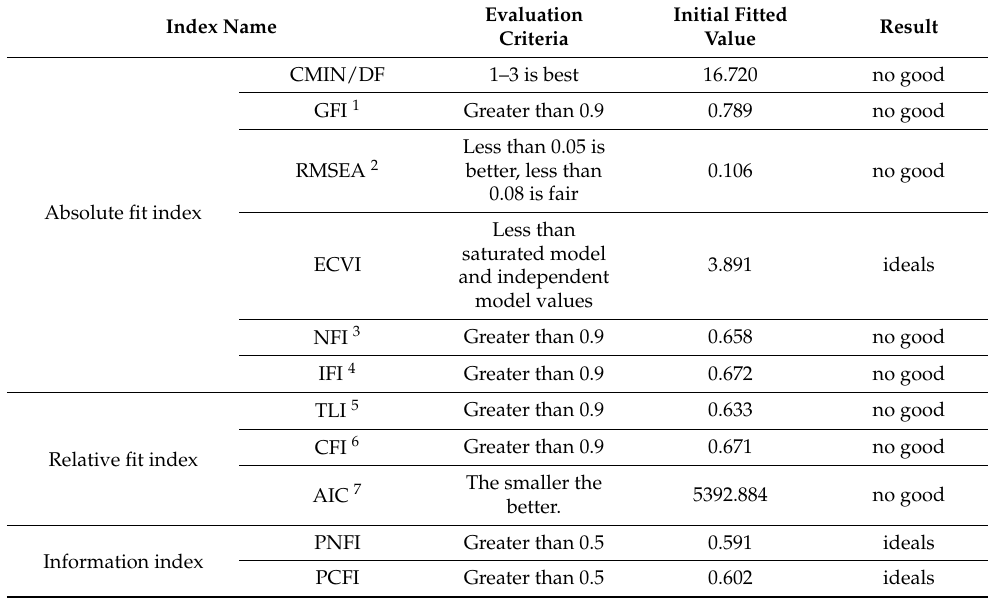
Figure 2. Initial path of willingness to digitally upgrade rural e-commerce. Table 4. Evaluation index system and fitting results of the overall fitness of the structural